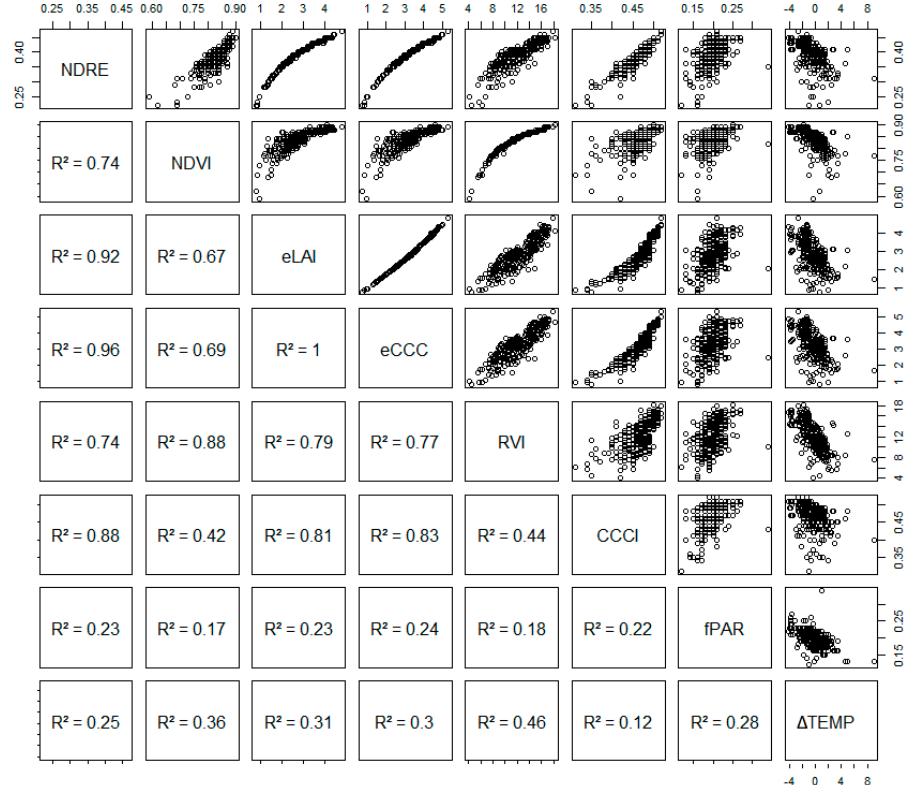
Figure 4. Correlation pairs between the Crop Circle Phenom metrics. Upper panel displays the relationship between sensor metrics and lower corner panel shows coefficient of determination (R 2 ).